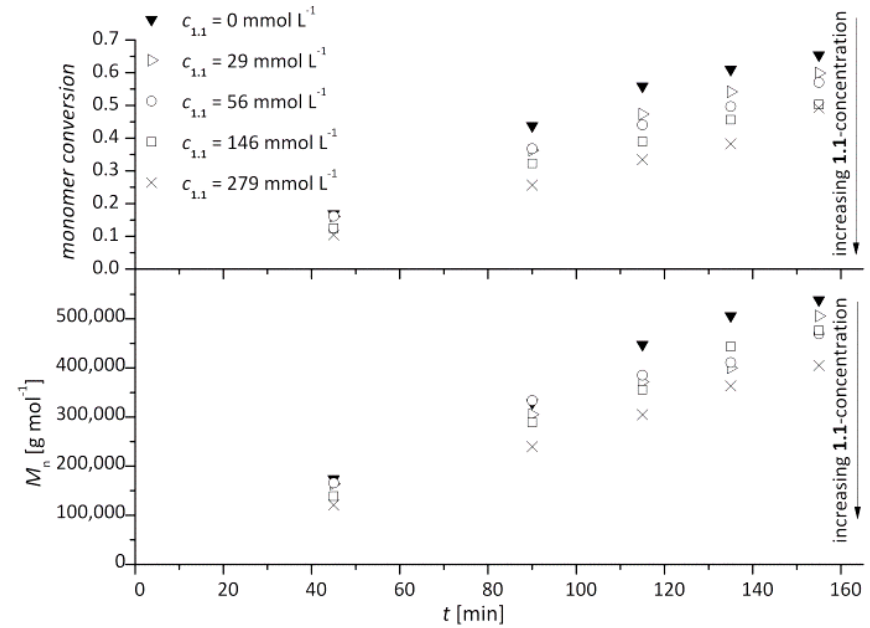
Figure 5. Developments of monomer conversion and number average molecular weight with time in homopolymerization of BA and in different copolymerizations of BA and